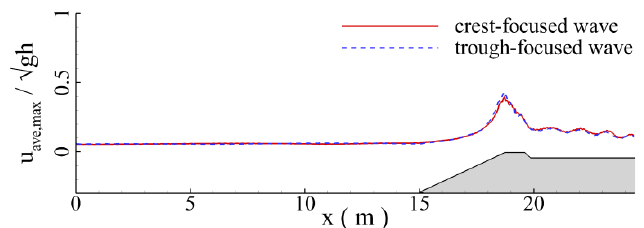
Figure 11. Space distribution of the local maximum depth-averaged velocity.